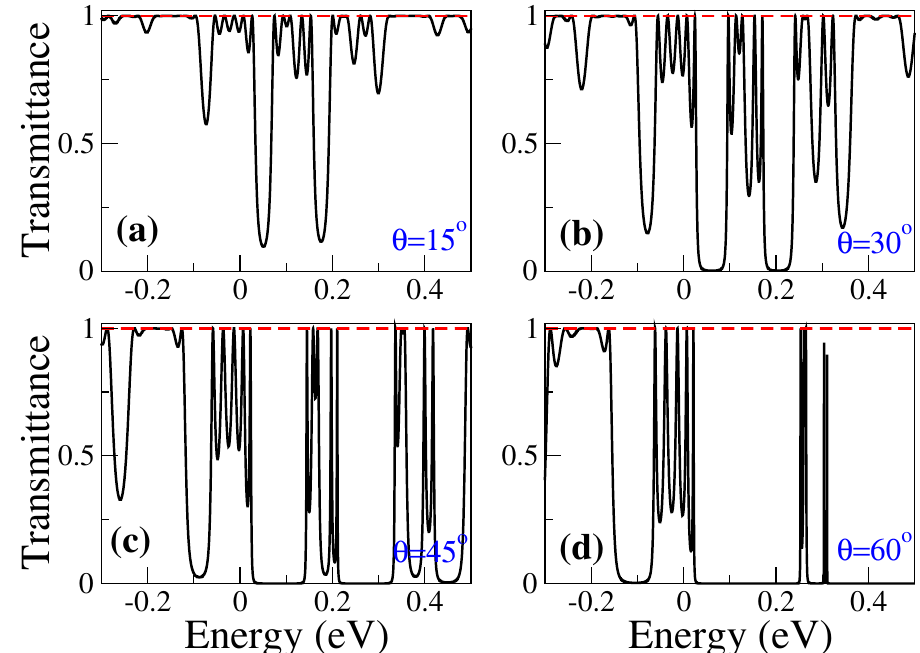
Figure 2. Transmittance as a function of the energy for BPGGSLs with d W 1 > d W 2 . Different incident angles have been considered: ( a ) θ = 15 ◦ , ( b ) θ = 30 ◦ , ( c ) θ = 45 ◦ and ( d ) θ = 60 ◦ . In all cases the perfect transmission at normal incidence θ = 0 ◦ (dashed-red curve) is a manifestation of the Klein tunneling. Here, the superlattice parameters are: V 0 = 0.1 eV, d B = 50 a , d W 1 = 60 a , d W 2 = 50 a and N = 3